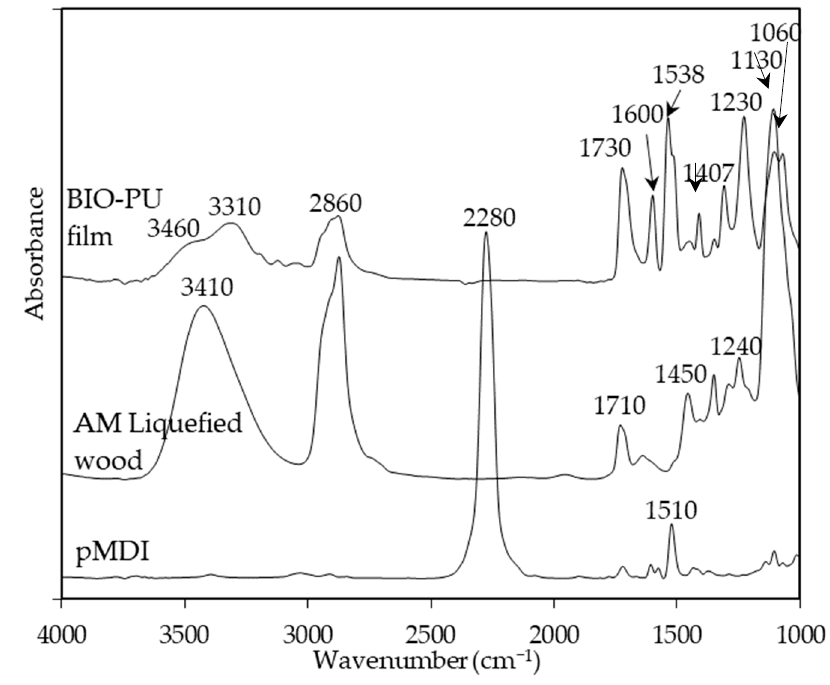
Figure 1. FT-IR spectra of BIO-PU film, AM liquefied wood and pMDI.